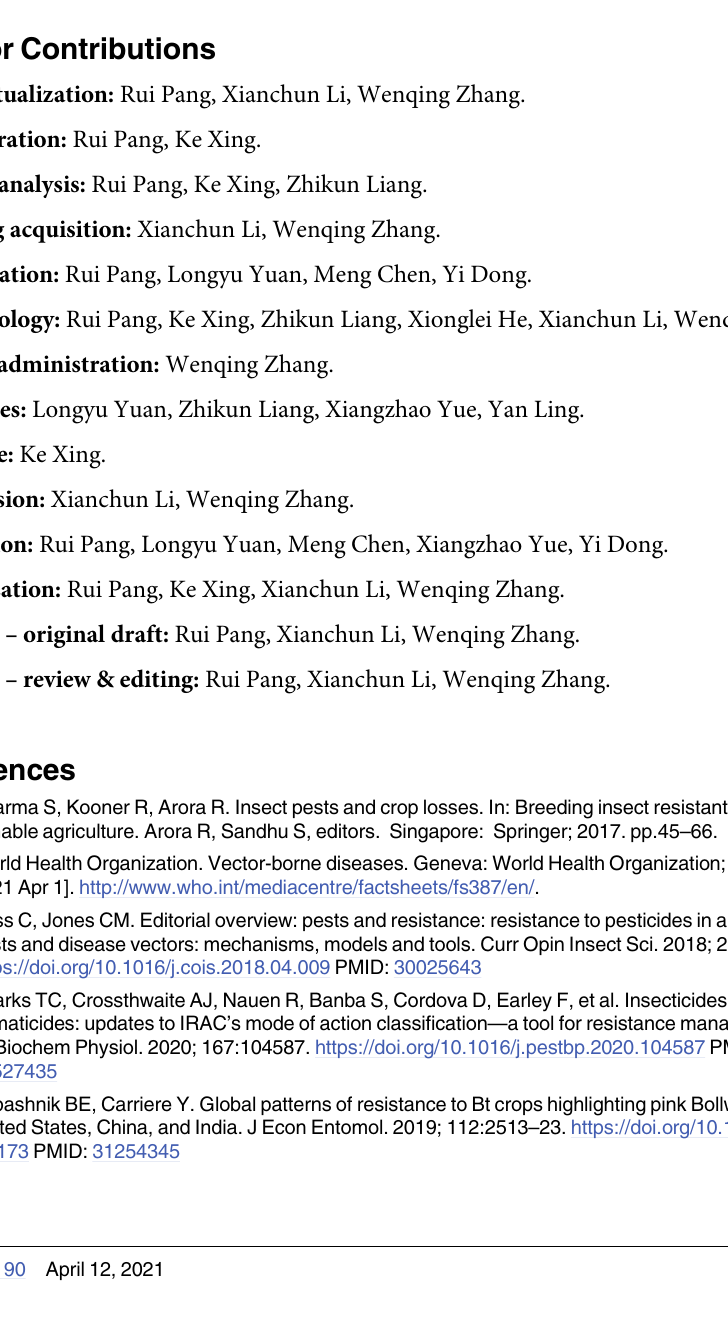
S5 Table. GO functional enrichment of candidate genes. S6 Table. The primers used in this